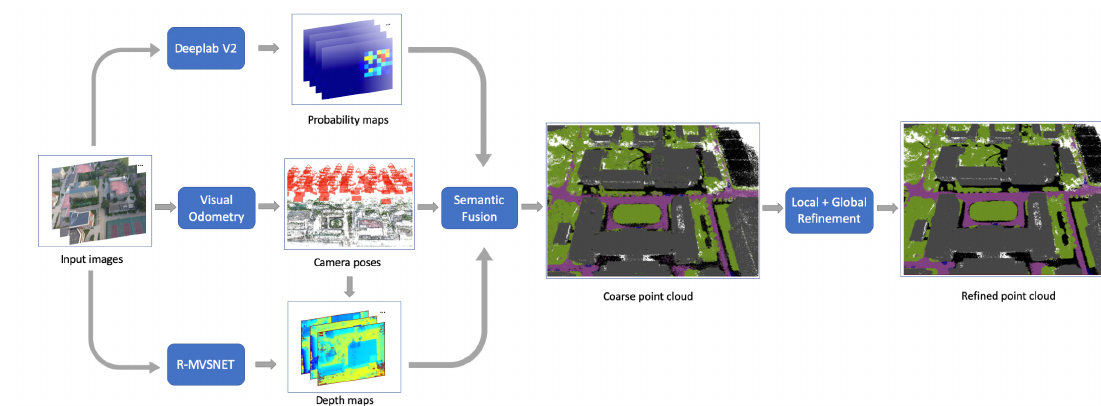
Figure 1. General pipeline of our work. Three branches are implemented to process the reconstruction dataset. The upper branch is the semantic segmentation branch to predict the semantic probability map; the middle branch is SfM to calculate the 3D odometry and camera poses; the lower branch is to estimate the depth map. Then, semantic fusion is applied to fuse them into a coarse point cloud. The last step is to refine the point cloud by local and global